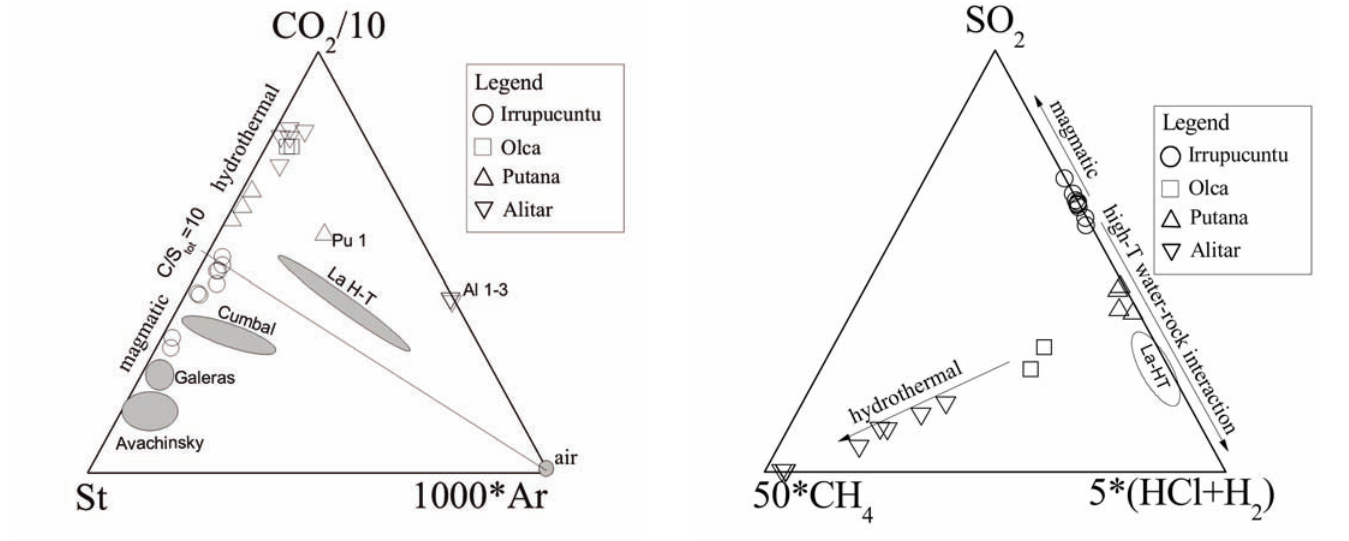
Figure 6 (left). Ar-CO -(SO +H S) ternary diagram for the Irruputuncu (open circles), Olca (open squares), Putana (open triangles up) and Alitar (open 2 2 2 triangles down) fumarole gases. For comparison, the compositions of Lascar (La-HT) [Tassi et al. 2009], Avachinski (Kamchatka) [Taran et al. 1997], Galeras (Colombia) [Fischer et al. 1997] and Cumbal (Colombia) [Lewicki et al. 2000] gases are also shown. Figure 7 (right). (HCl+H )-SO -CH ternary diagram. Symbols as in legend to Figure 6. For comparison, the composition of the Lascar gases (La-HT) 2 2 4 [Tassi et al. 2009] is also